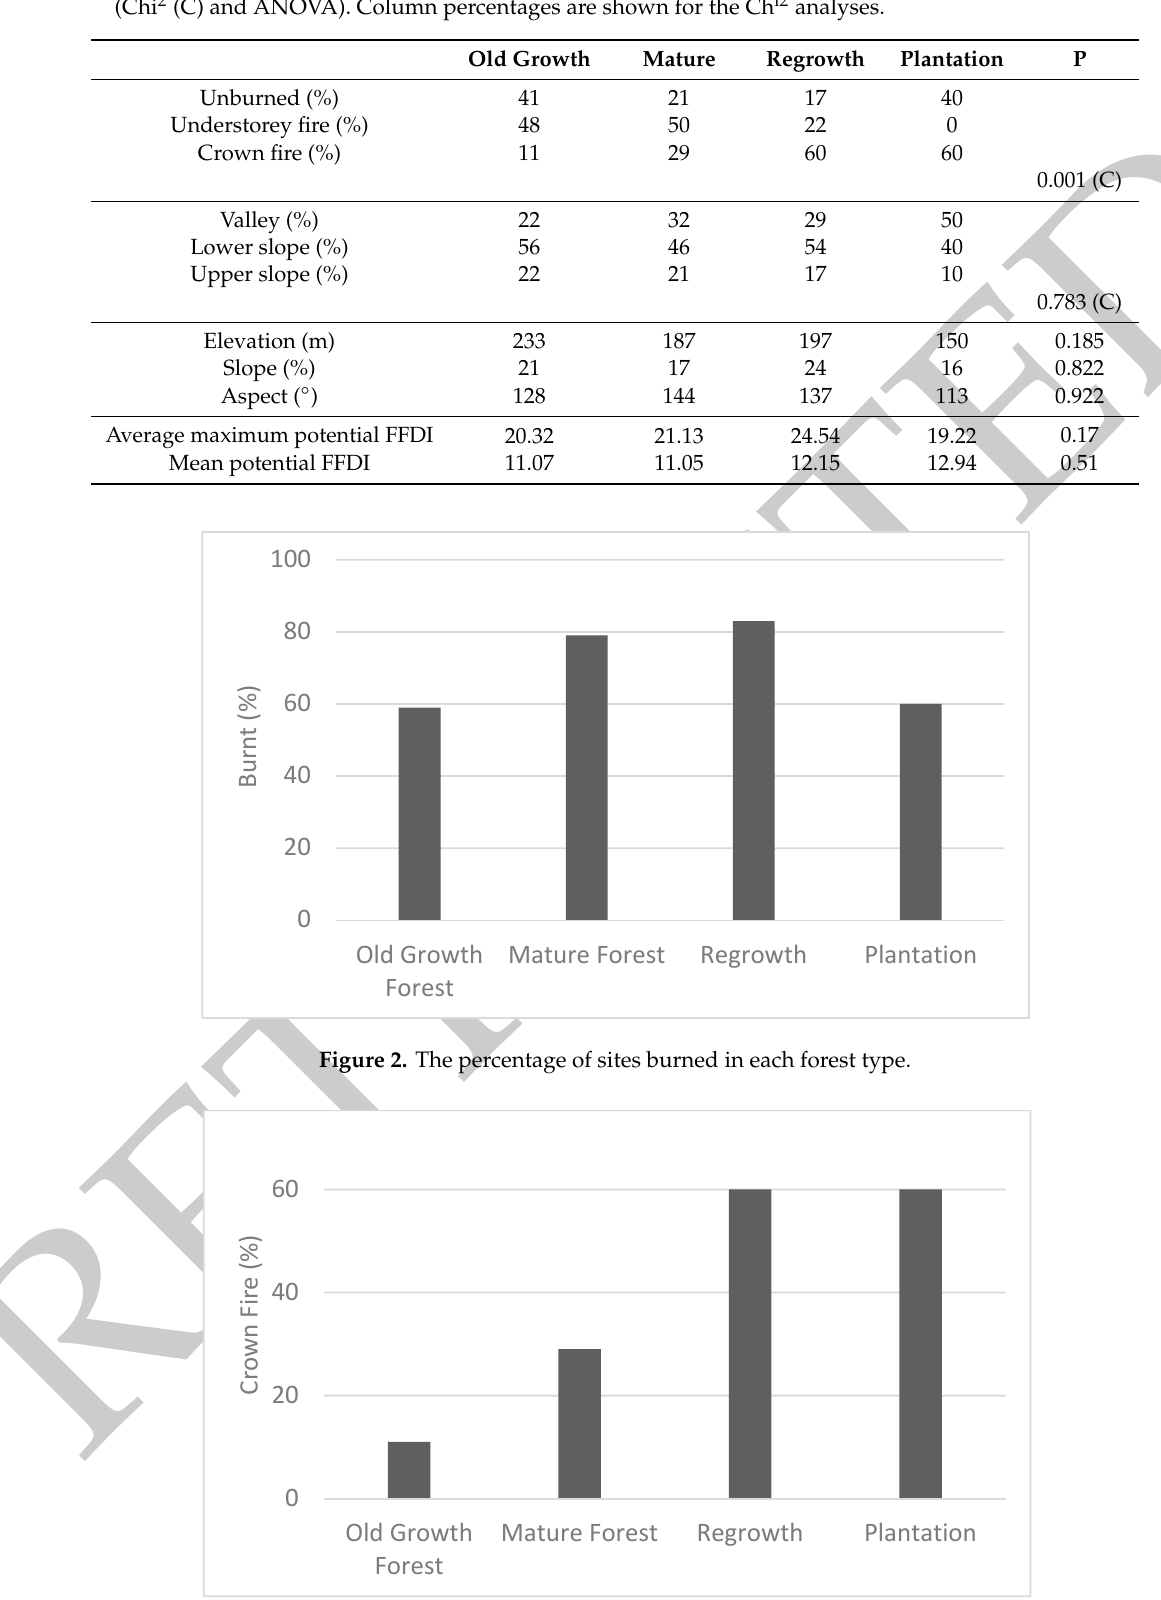
Figure 3. The percentage of sites that experienced crown fire.